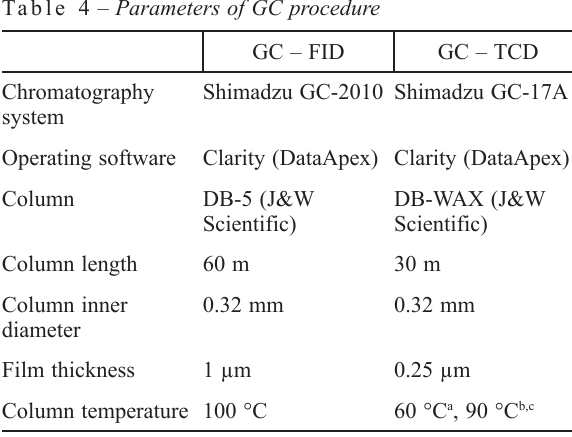
Table 4 – Parameters of GC